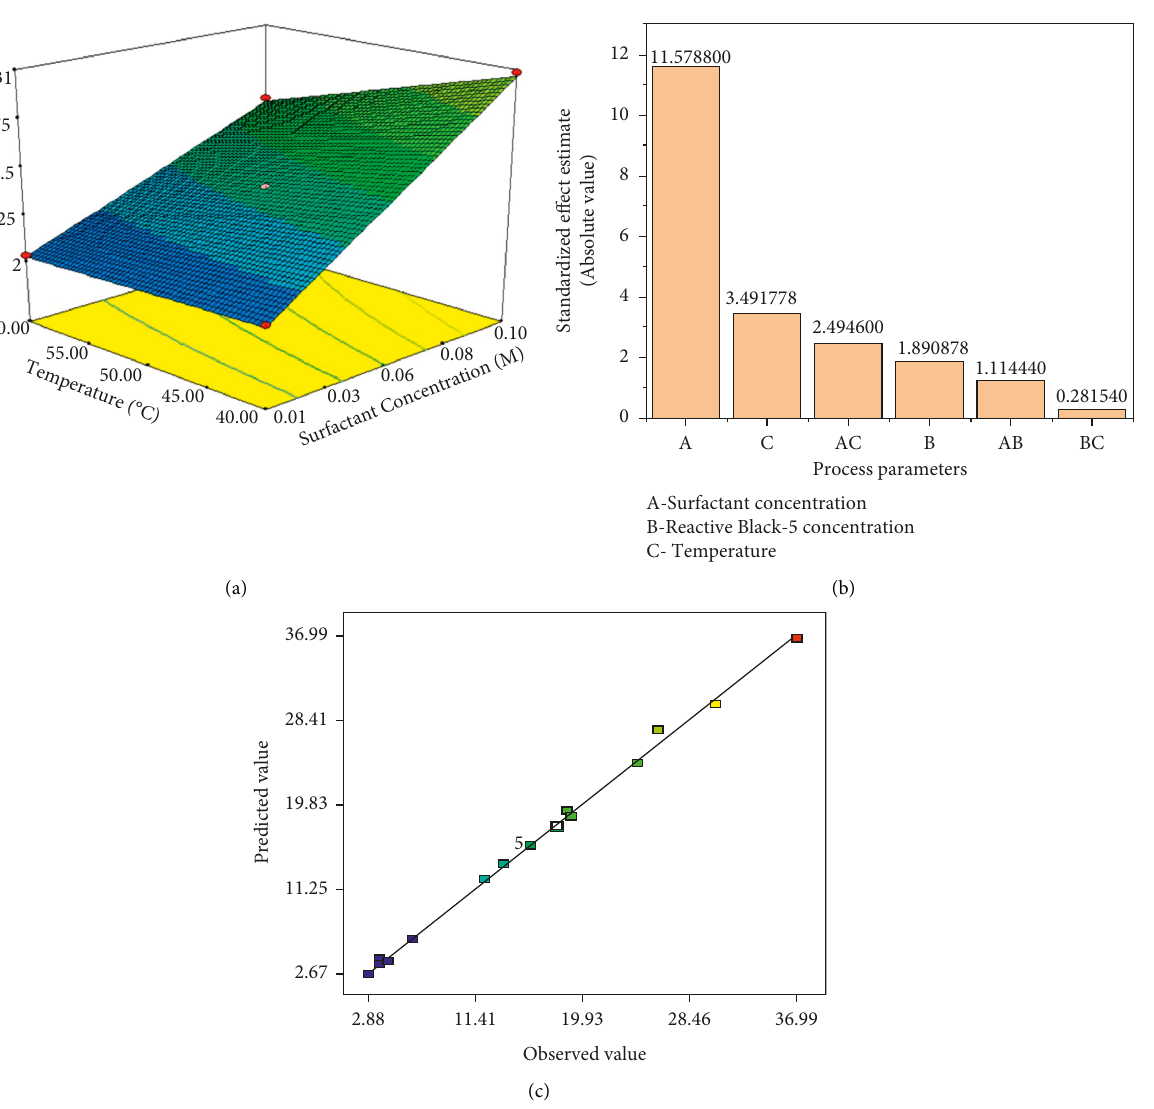
Figure 6: (a) Response surface for dye concentration in the dilute phase after separation. (b) Pareto chart for dye concentration in the dilute phase after separation. (c) Comparison between predicted and observed values of dye concentration in the dilute phase after